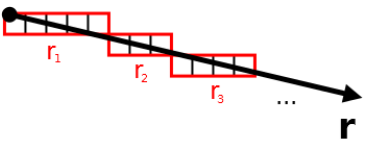
Figure 2. Runs r 1 , r 2 , r 3 (red) of the rasterized line r with a length of five, three and four pixels altered by one pixel in the minor line direction, and the run se- quence gets rewound to its start.